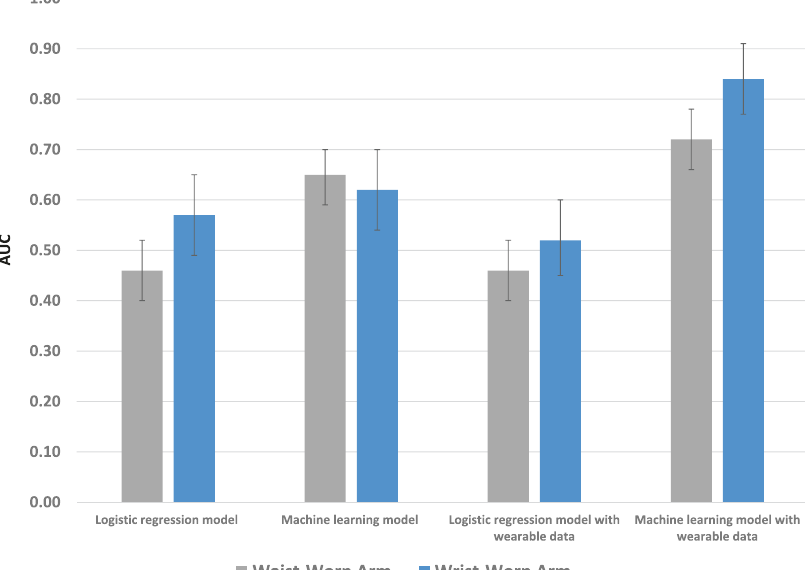
Fig. 4 Prediction of hemoglobin A1c improvement. Represents prediction for a decrease in hemoglobin A1c of ≥ 0.3. Displayed by type of model (logistic regression or ensemble machine learning), use of data (with or without wearable data), and type of wearable (waist or wrist). Data presented are Area Under the Curve (AUC) and 95% con fi dence intervals from the testing